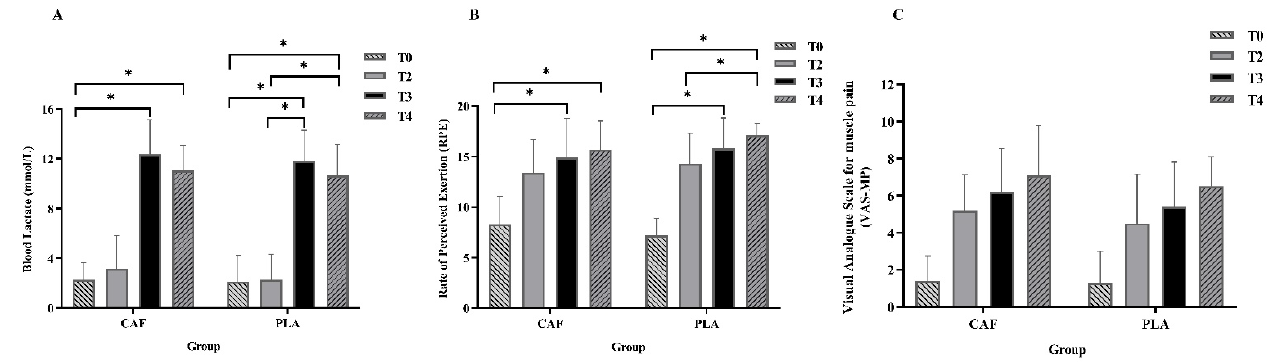
Figure 4. Results of blood lactate, RPE, and VAS-MP at different time points. ( A ) Blood lactate; ( B ) RPE; ( C ) VAS-MP. RPE = Rating of perceived exertion; VAS-MP = Visual Analogue Scale for muscles pain. * Significantly different between different time points ( p < 0.05).